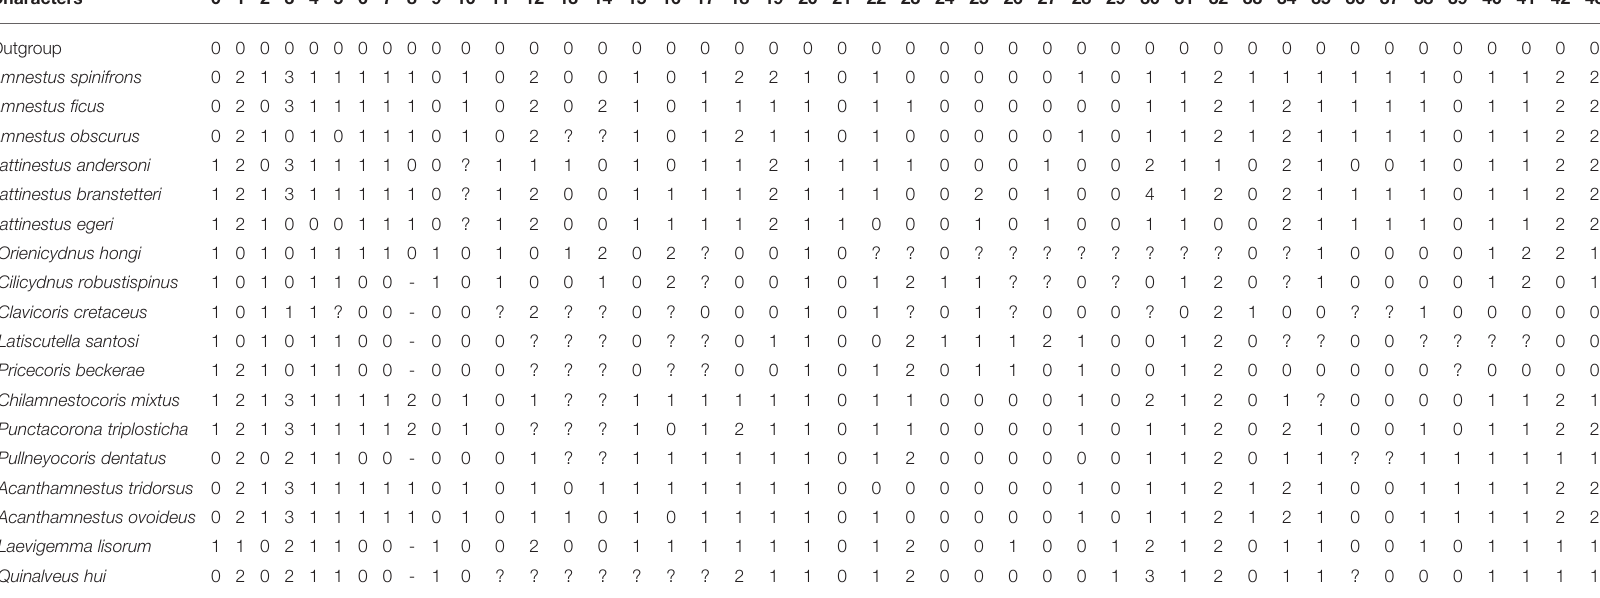
TABLE 1 | Character matrix for phylogenetic analyses, including 43 morphological characters for 19 taxa.